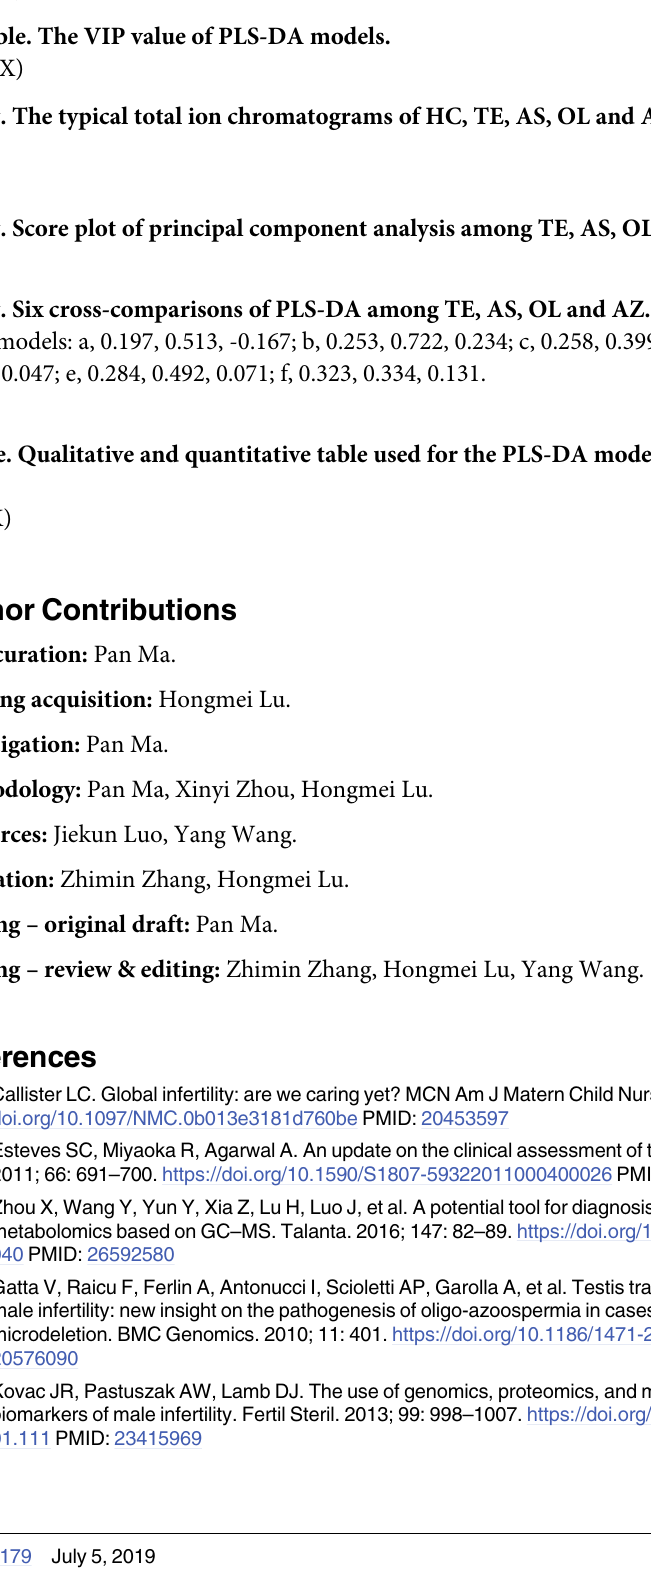
S2 Table. Statistical analysis of age, smoking and drinking among SA subgroups and HC. S3 Table. The p-value of ANOVA with Dunnett post-hoc test. S4 Table. The VIP value of PLS-DA models. S1 Fig. The typical total ion chromatograms of HC, TE, AS, OL and AZ blood plasma sam- ples. S2 Fig. Score plot of principal component analysis among TE, AS, OL, AZ and HC. S3 Fig. Six cross-comparisons of PLS-DA among TE, AS, OL and AZ. The R 2 X, R 2 Y and Q 2 of six models: a, 0.197, 0.513, -0.167; b, 0.253, 0.722, 0.234; c, 0.258, 0.399, -0.21; d, 0.241,